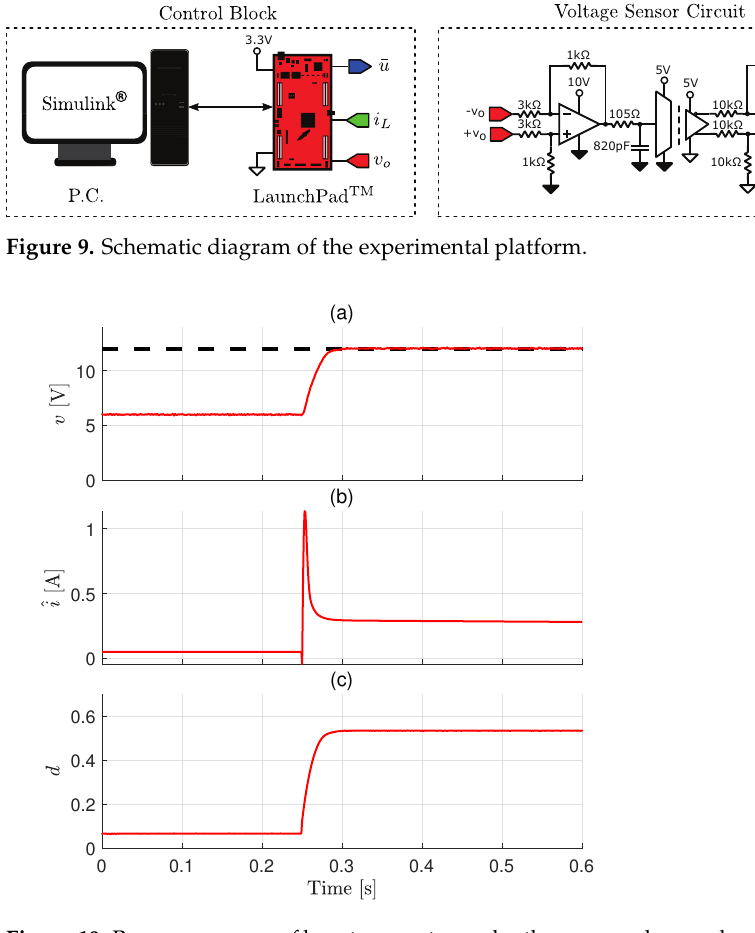
Figure 10. Response curves of boost converter under the proposed sensorless controller (experiment). ( a ) Output voltage v , ( b ) estimated current i , ( c ) duty ratio d